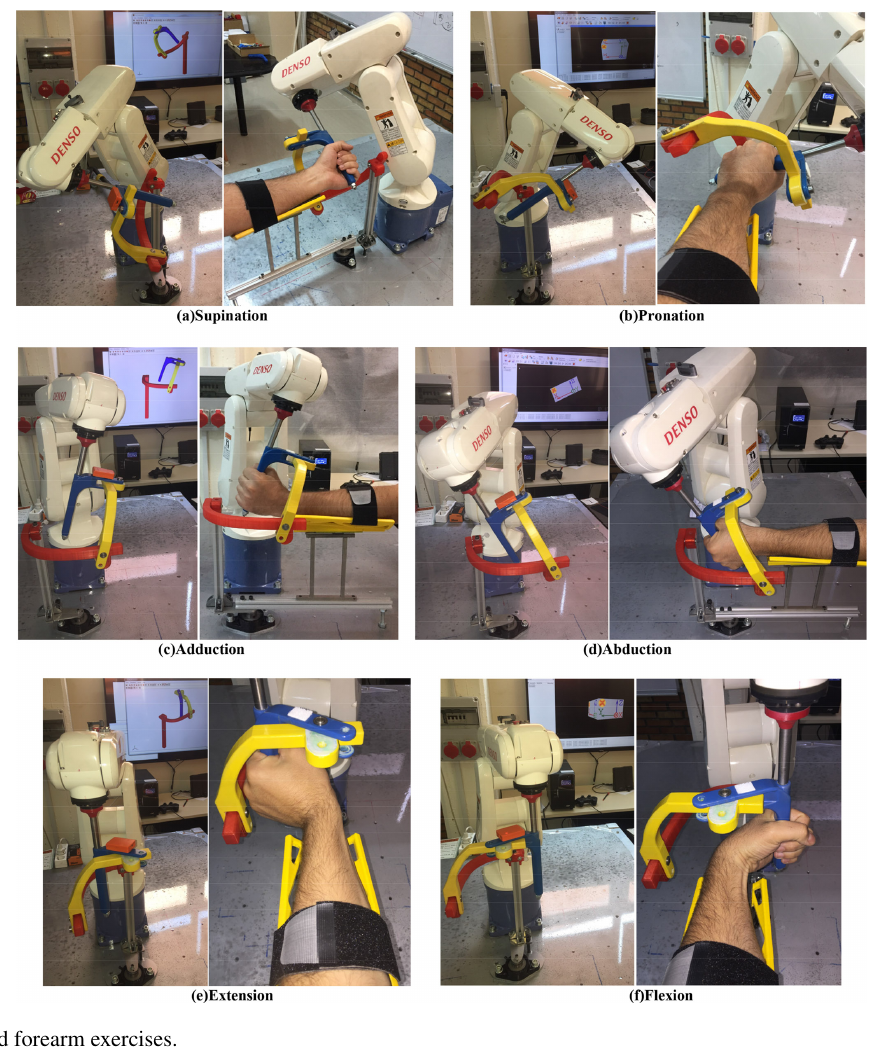
Figure 16. Wrist and forearm